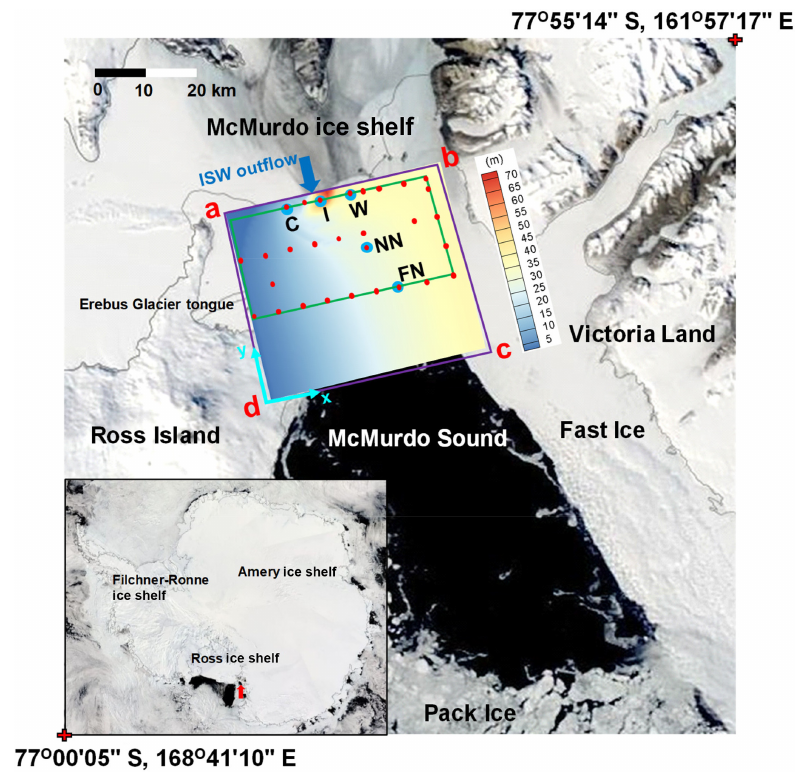
Figure 1. Satellite image of McMurdo Sound region on 29 November 2011. Purple and green frames outline the model and ice borehole (Fig. 6) domains, respectively. Colours within the purple frame indicate the steady-state supercooled ISW plume thickness calculated by the vertically modified ISW plume model in the standard run (Fig. 5d). Light-grey lines outline McMurdo Ice Shelf front and coastlines. Model boundaries “d–a”, “a–b” (except the ISW outflow) and “b–c” are treated as solid walls, while “c–d” is an open boundary. Blue and red dots respectively mark the oceanographic CTD and ice drilling sites, and the blue arrow represents the location of the ISW outflow in the model. The red arrow in the inset (bottom-left) points to the location of the McMurdo Sound region. Location names C, I, W, NN, and FN mean central, intermediate, west, near north, and far north, respectively. Satellite image: NASA Rapid Response MODIS Subsets (https://worldview.earthdata.nasa.gov/, last access: 3 Jauary